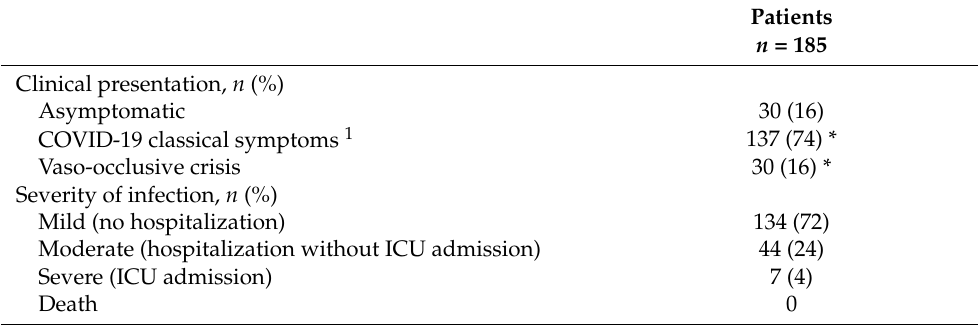
Table 2. Clinical presentation and outcomes of SCD patients infected by COVID-19.